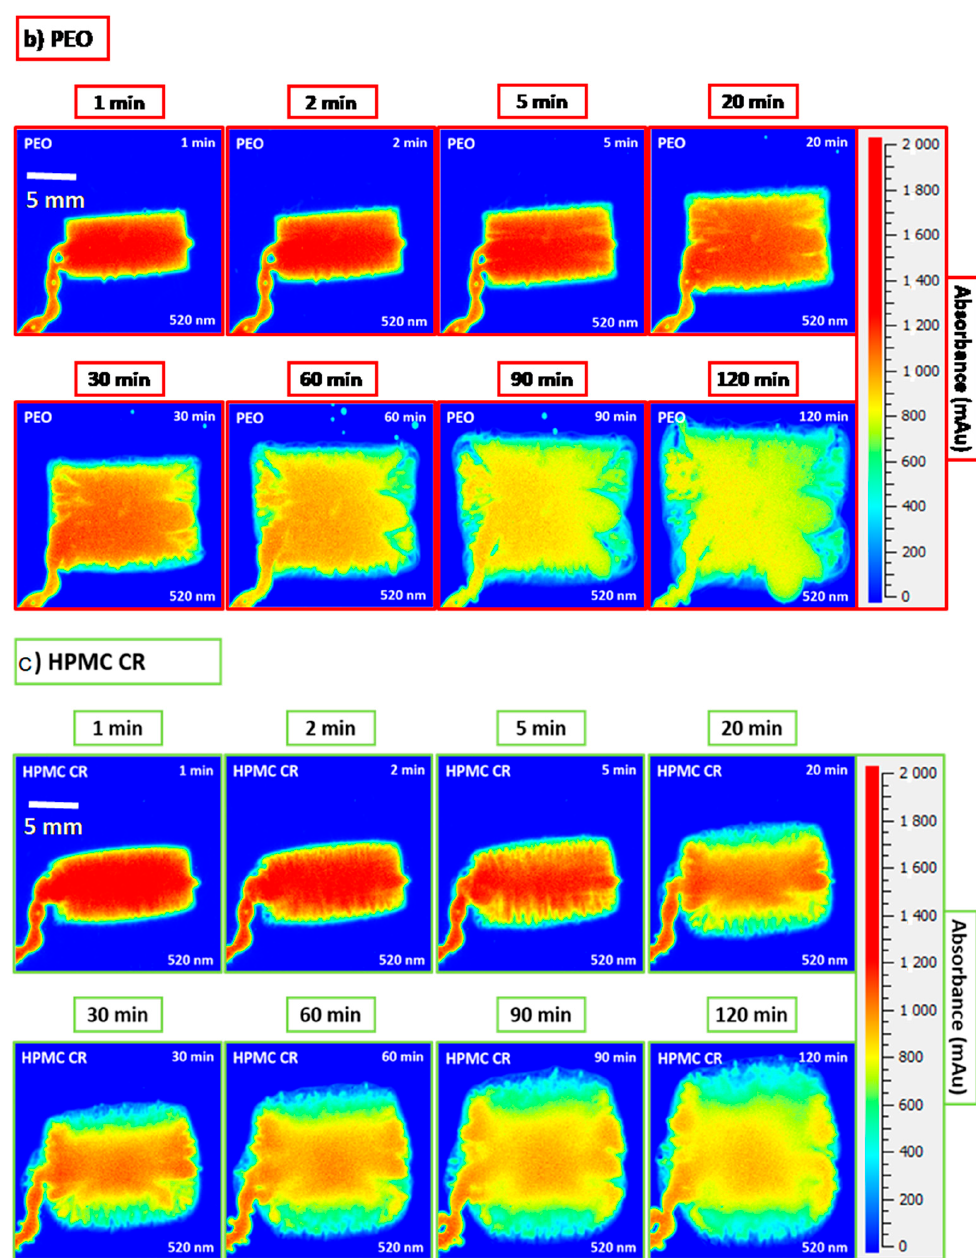
Figure 6. Optical images obtained from the dissolution imaging system at the 520 nm wavelength: ( a ) XG, ( b ) PEO, and ( c ) HPMC CR. Note: Images are taken from the 2 h experiment at time intervals of 1, 2, 5, 20, 30, 60, 90 and 120 min. XG is xanthan gum, PEO is polyethylene oxide, and HPMC CR is hypromellose K100M CR